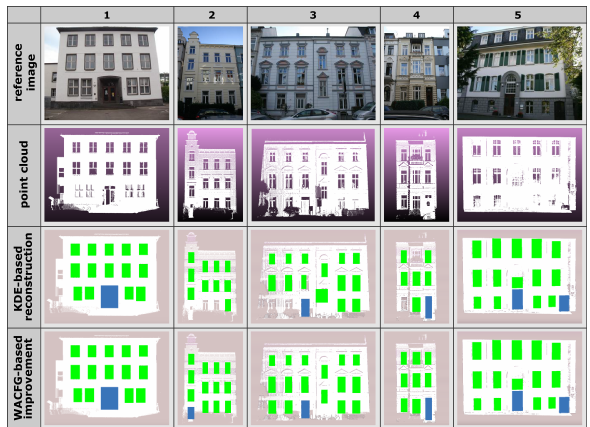
Figure 1: 3D fac¸ade reconstruction based on statistical relational learning (SRL) (Dehbi et al., 2017a).